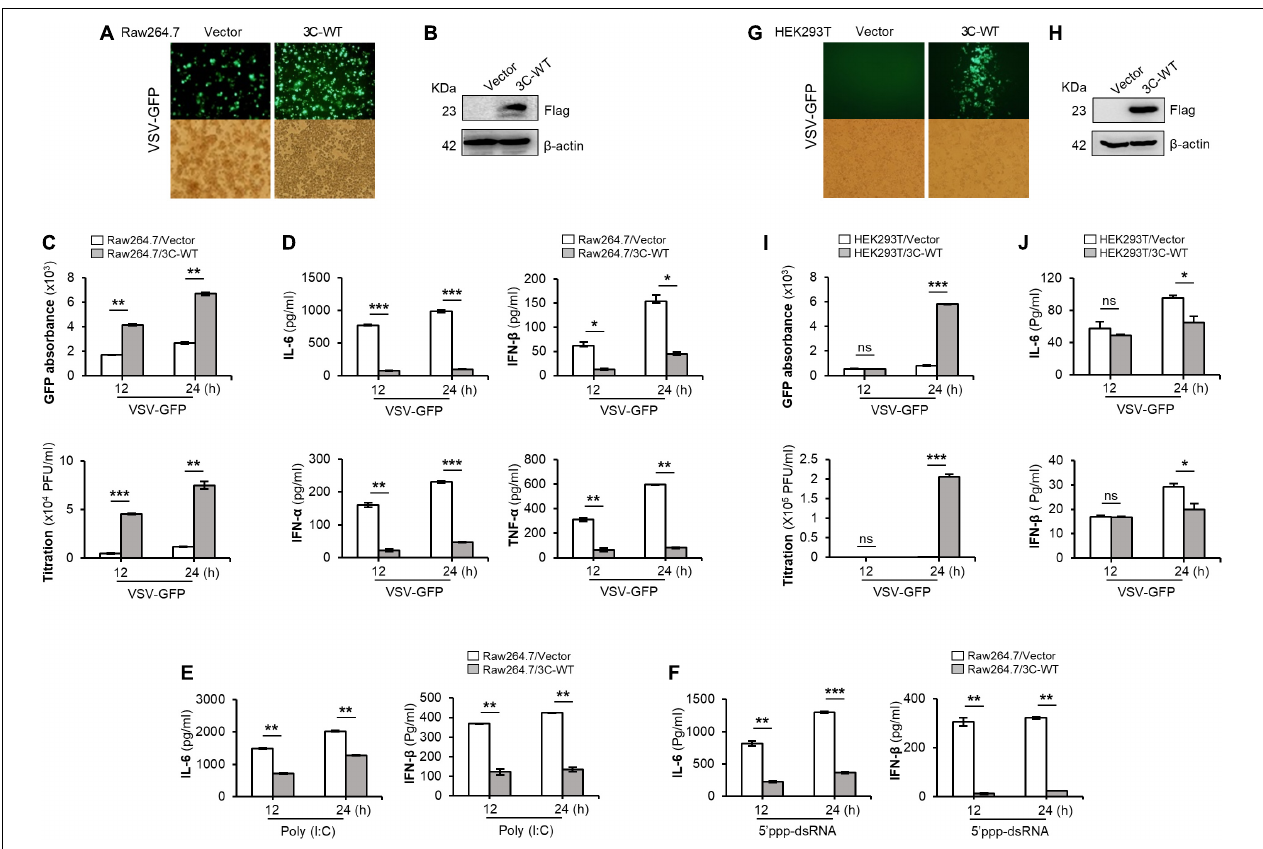
FIGURE 1 | Wild-type FMDV 3C pro negatively regulates type-I IFN pathway. Wild-type FMDV 3C pro stably expressing or control Raw264.7 cells were infected with VSV-GFP (1 MOI) at indicated time points and, (A) GFP expression, (B) FMDV 3C pro expression, (C) GFP absorbance and virus titer, and (D) IL-6, IFN- β , IFN- α , and TNF- α secretion was measured. The same cell line was treated with (E) poly (I:C) or (F) 5 (cid:48) PPP-dsRNA and measured their IL-6 and IFN- β secretion. HEK293T cells were transiently transfected with control plasmid or wild-type FMDV 3C pro plasmid, and VSV-GFP (0.5 MOI) were infected. At indicated time points (G) GFP expression, (H) FMDV 3C pro expression, (I) GFP absorbance and virus titer, and (J) IL-6, IFN- β secretion was measured at indicated time points. Data are representative of three independent experiments, each with similar results. FMDV, foot-and-mouth disease virus; IFN, interferon; IL-6, interleukin 6; TNF- α , tumor necrosis factor-alpha. All the values are expressed as mean ± SD of three biological replicates. Student’s t -test; * p < 0.05; ** p < 0.01; *** p < 0.001; ns, not